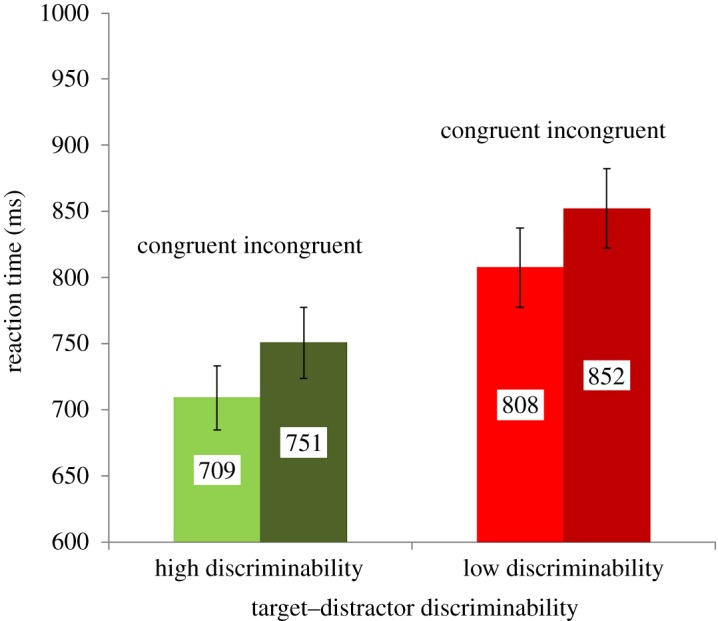
Reaction time as a function of congruency and target–distractor discriminability. Error bars represent standard errors of the mean.